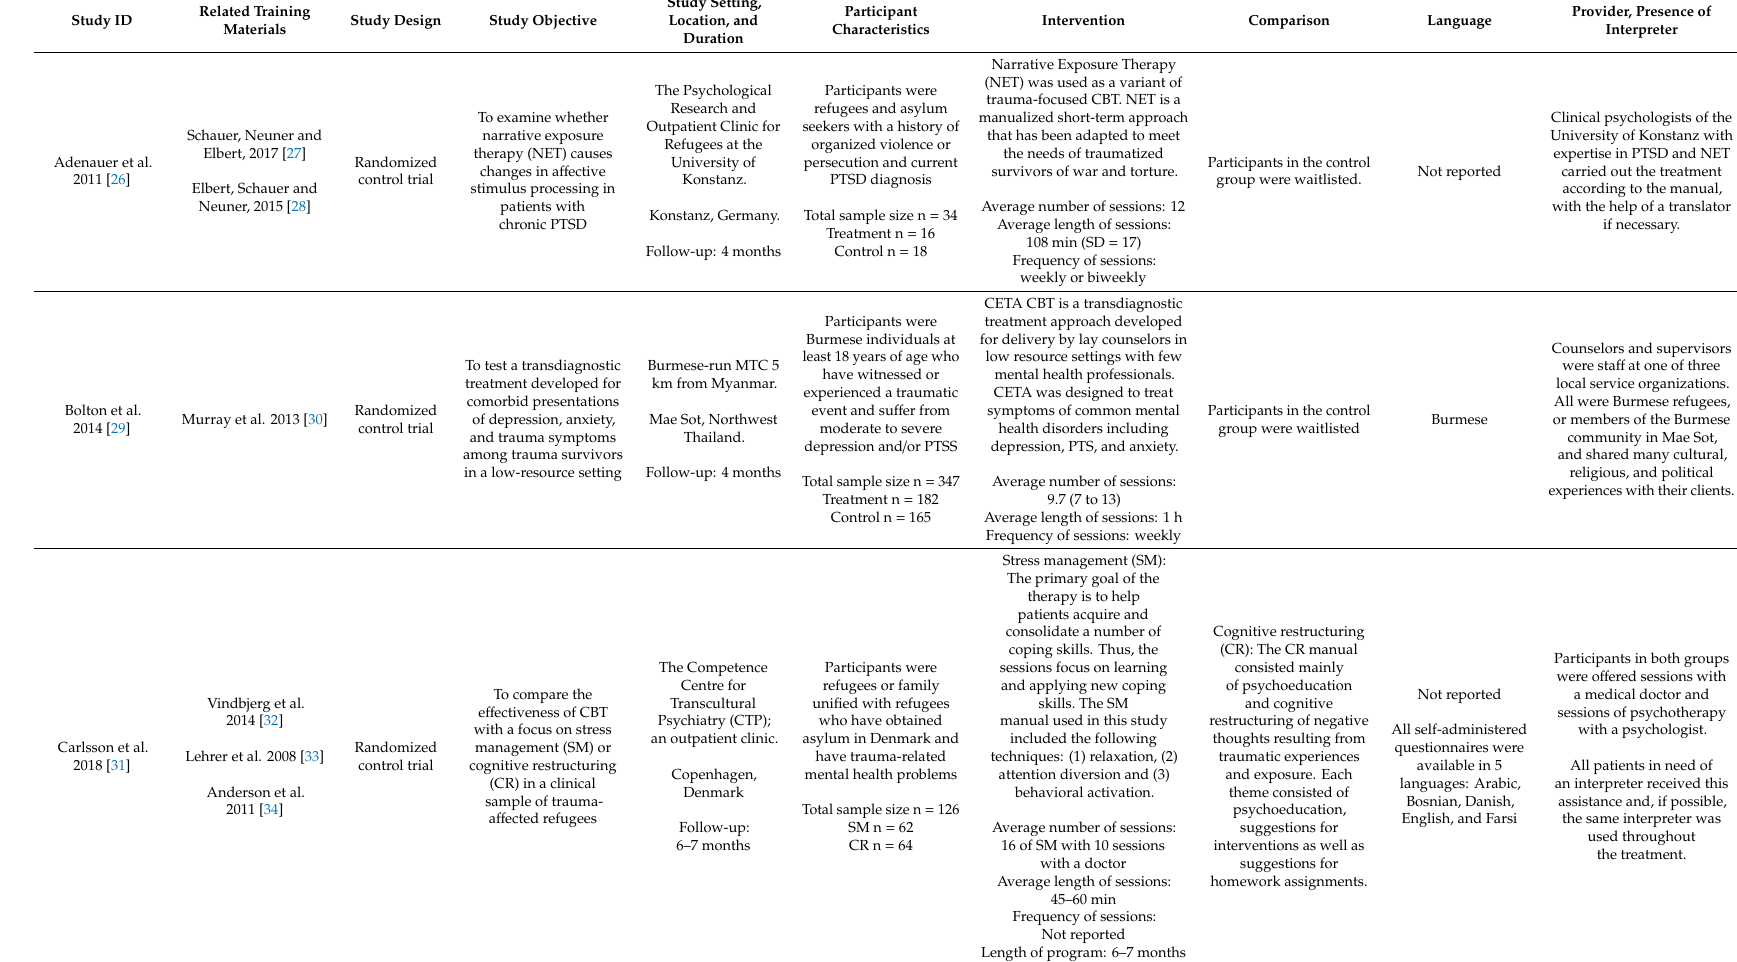
Table 3. Characteristics of Included